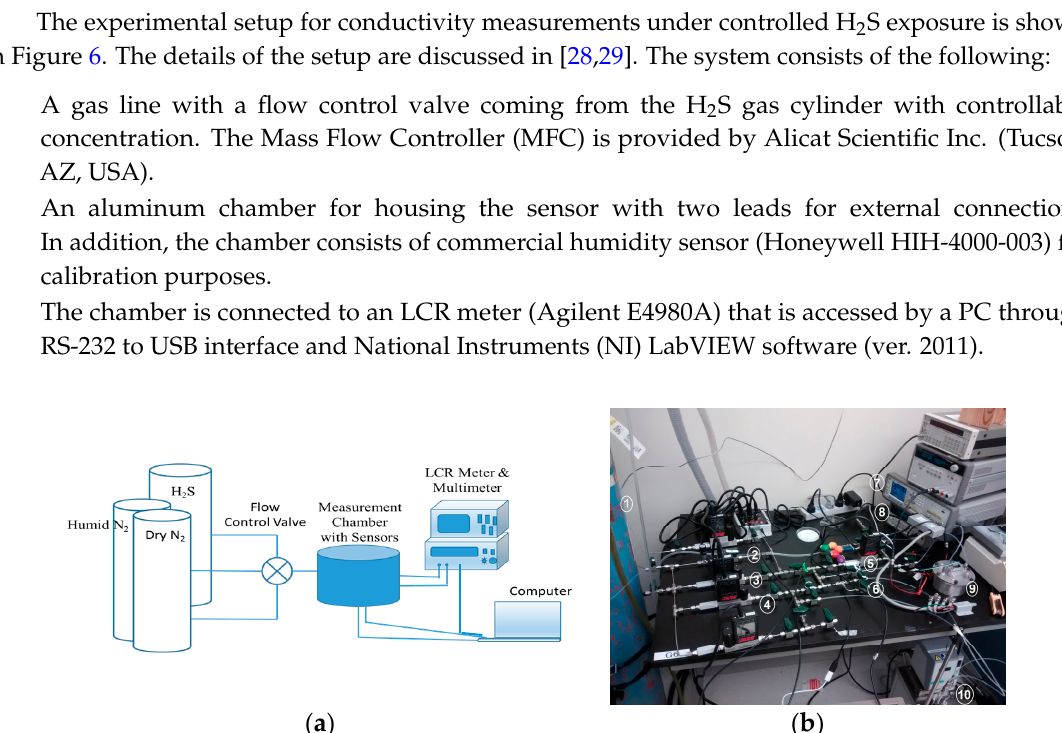
Figure 6. Measurement setup for humidity and gas sensing. ( a ) Block diagram; ( b ) Laboratory setup.